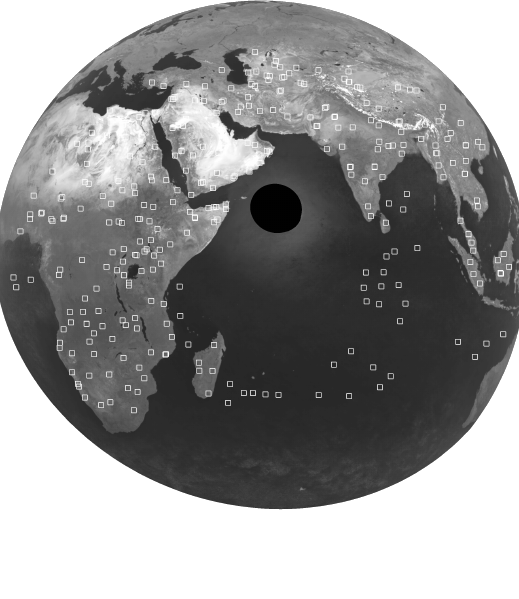
Figure 17. The 314 selected clear-sky stable sites on top of the Meteosat FOV above the Indian Ocean for the IODC of Meteosat-7 at 57 ◦